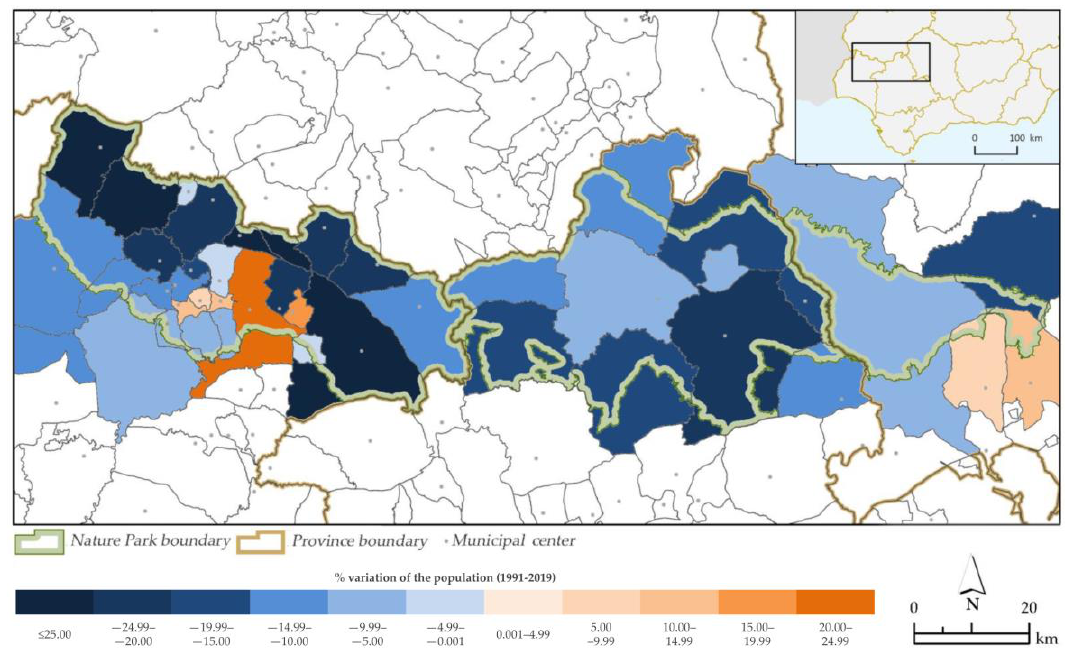
Figure 19. The variation of the population between 1991 and 2019. Source: [84]; authors ’ elaboration.